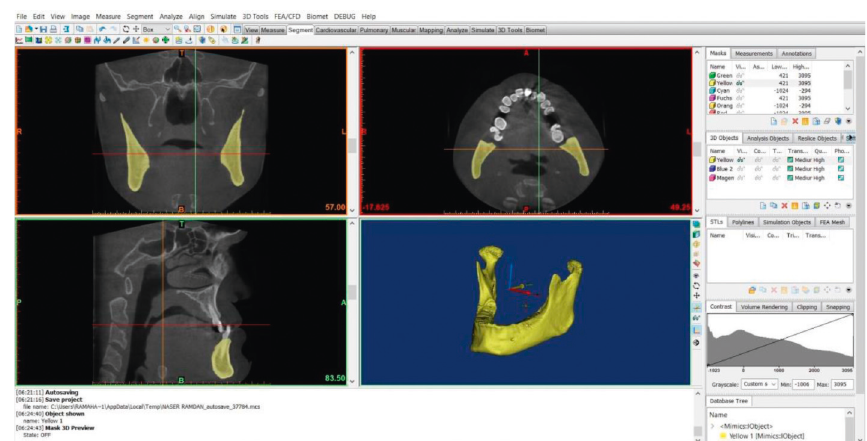
Figure 4: The solid final mandibular bone.